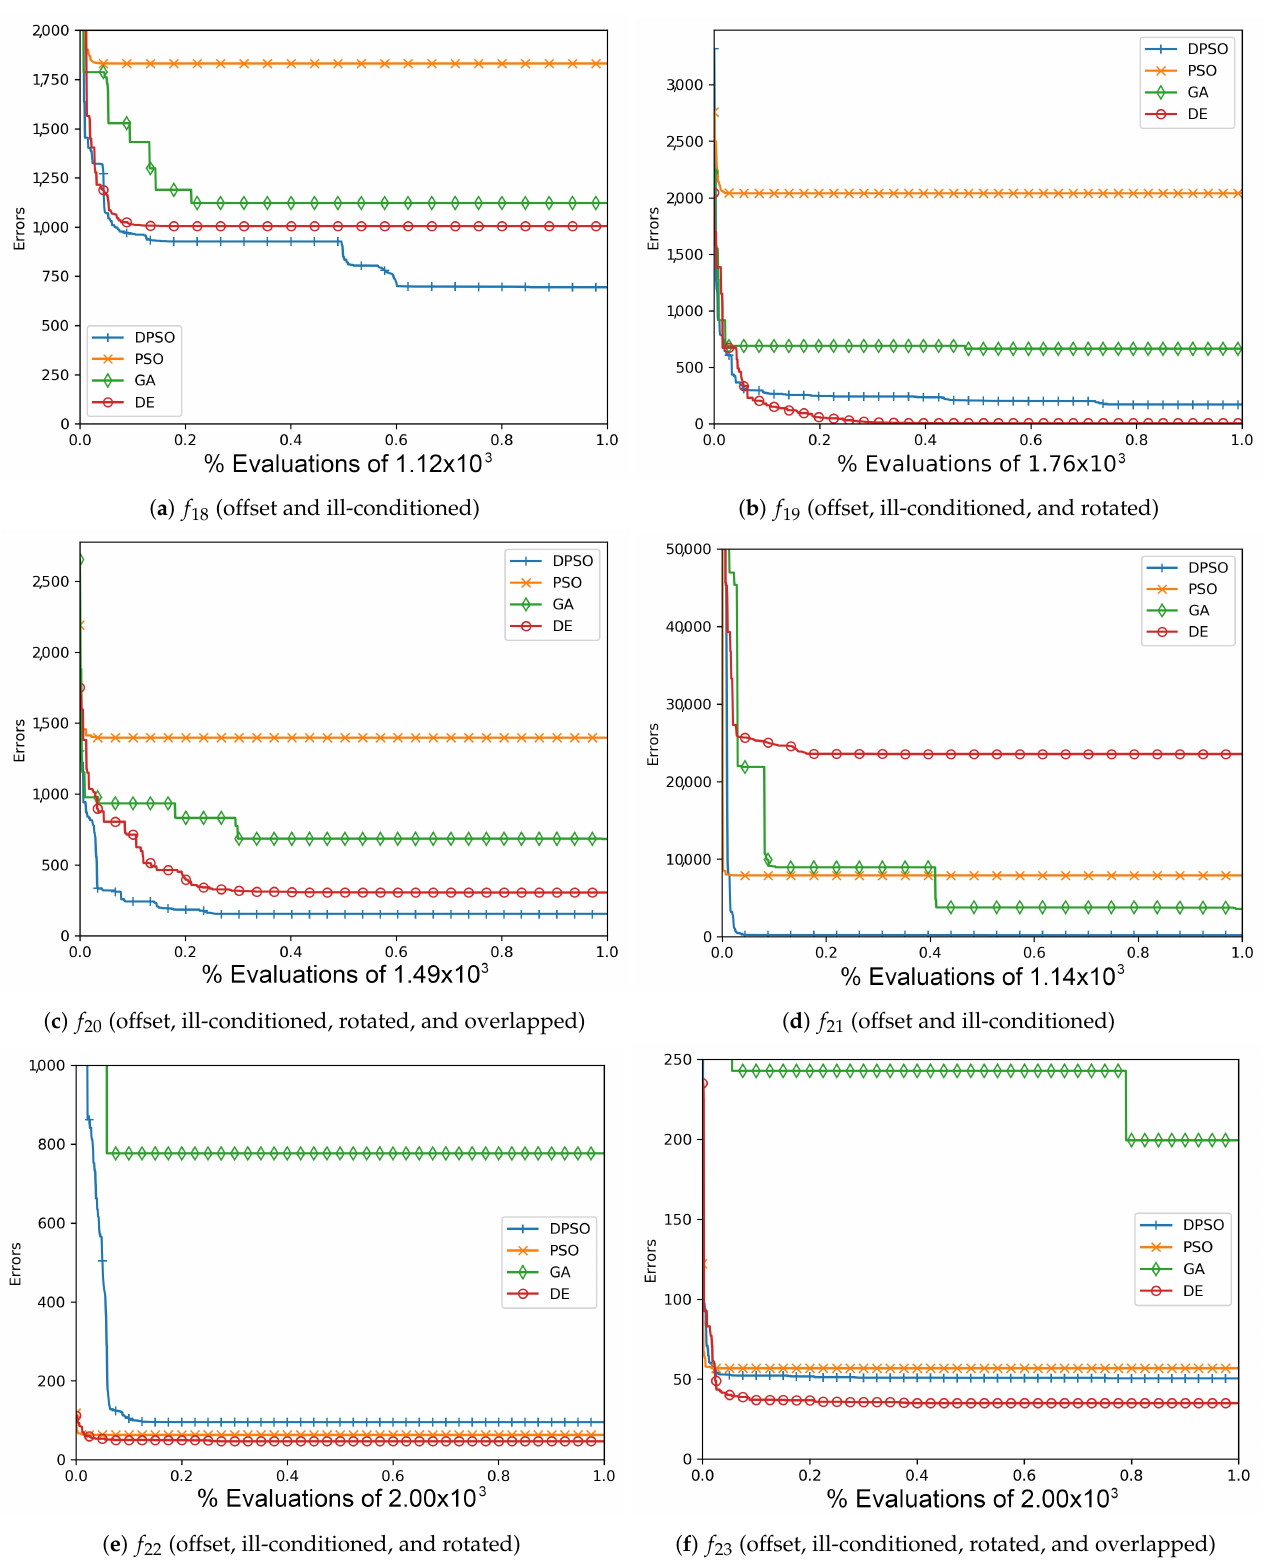
Figure A11. The average Zero-Sum ( f 18 , f 19 , f 20 ) and Salomon ( f 21 , f 22 , f 23 ) global best results over time for 14